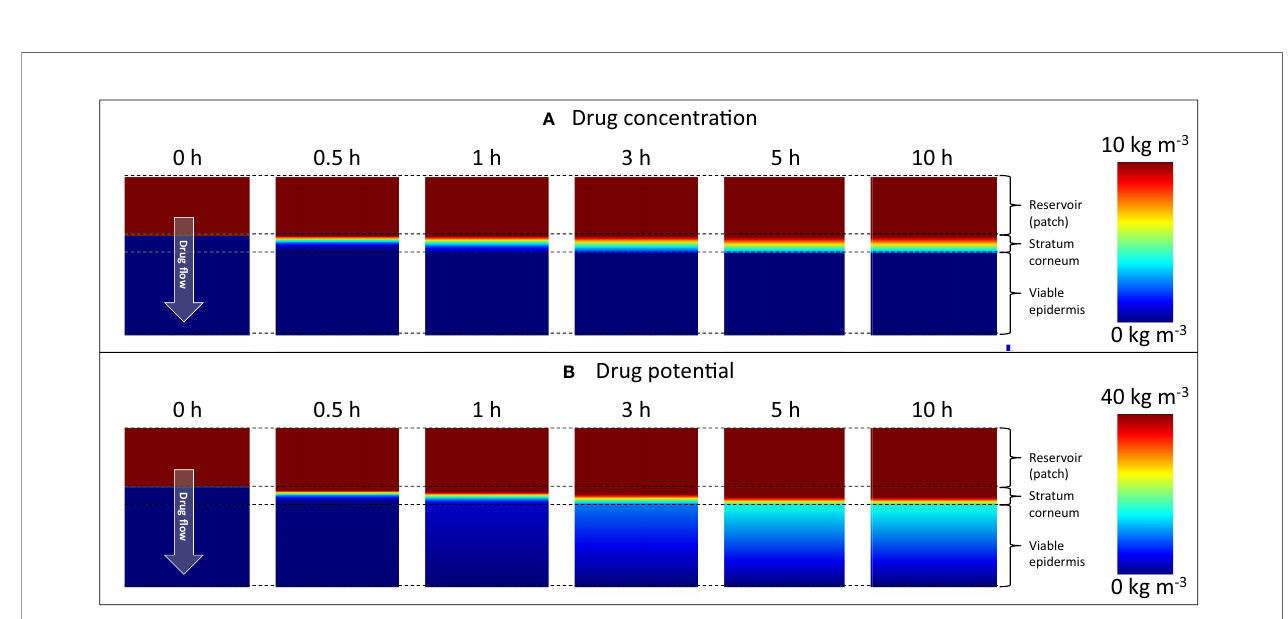
FIGURE 8 | Concentration pro fi les at different points in time as a function of the height of the model (z-direction, scaled with the epidermal thickness) in the vertical centerline (z-axis) of the patch for the base case: (A) entire model (logarithmic scale), (B) reservoir, (C) stratum corneum, (D) viable